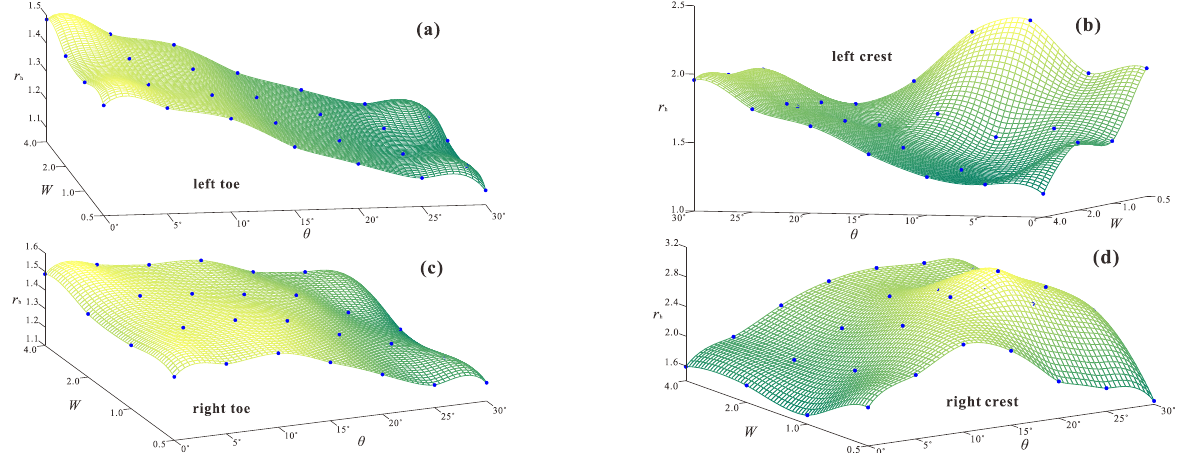
Figure 21. Variations of the seismic responses along the slope ridges and slope crests of the real amplification ratios ( r ) of PGA with varied angles of wave incidence at different slope widths, ( a ) slope width of 50 m, ( b ) slope width of 100 m, ( c ) slope width of 200 m ( d ) slope width of 400 m